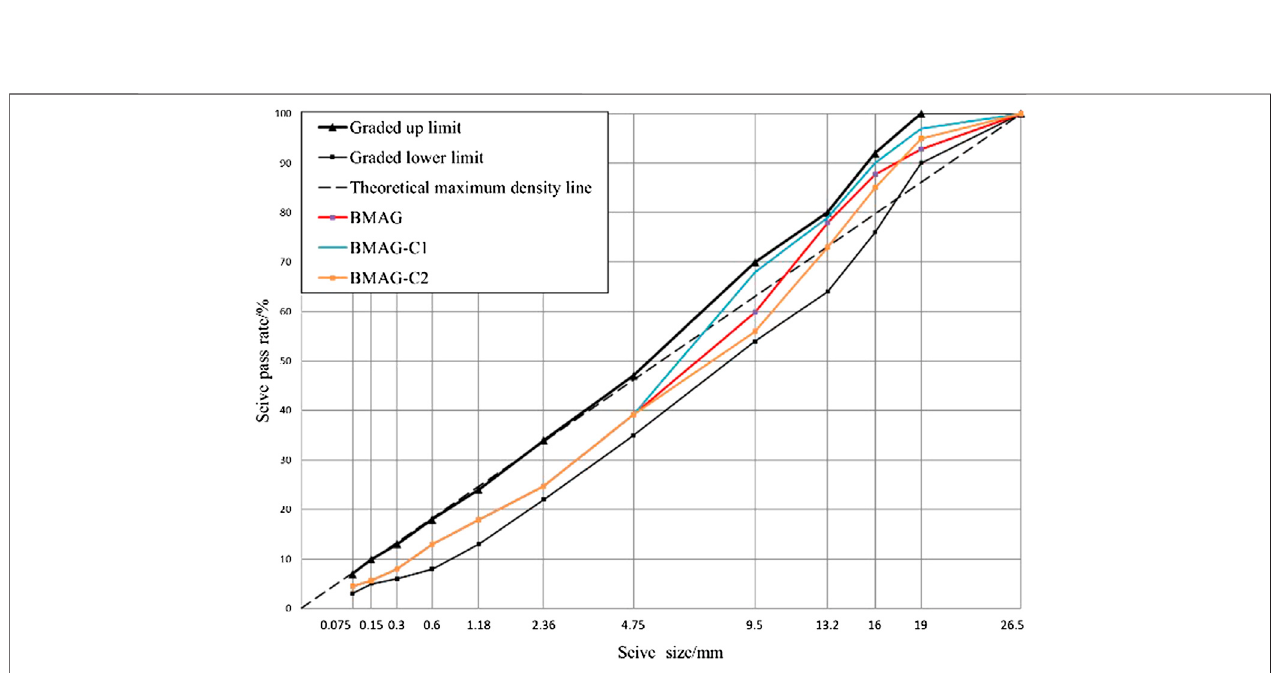
FIGURE 5 | Gradation curves of coarse aggregate